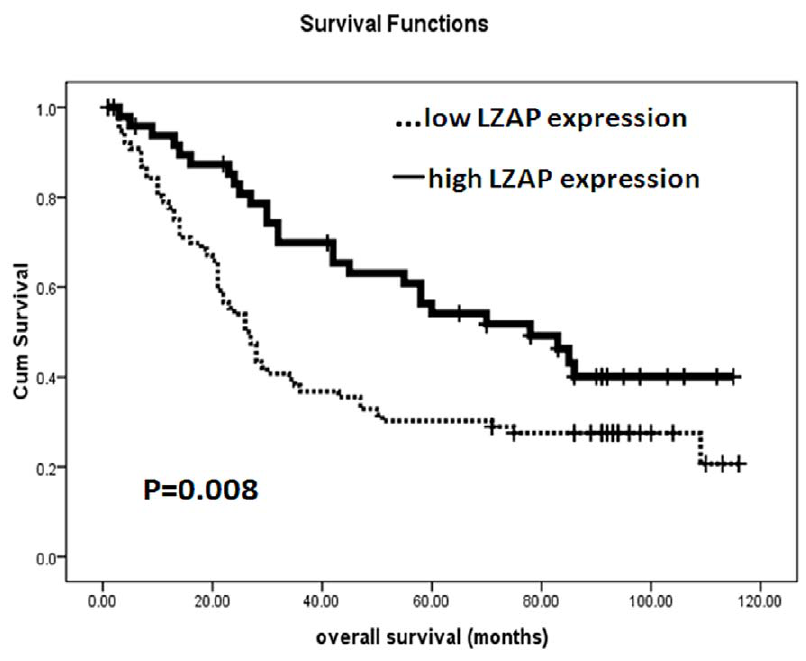
Figure 3. The Kaplan–Meier survival analysis of the primary HCC patients (n=126) with high LZAP expression (n=50) and low LZAP expression (n=76) after surgical resection. Based on their LZAP immunostaining scores, the HCC patients were divided into low-LZAP expression (LZAP 2 or LZAP + ) and high-LZAP expression (LZAP ++ or LZAP +++ ) groups. The survival rate of the patients in the low-LZAP group was significantly lower than that of the patients in the high-LZAP group (p=0.008 for the log-rank